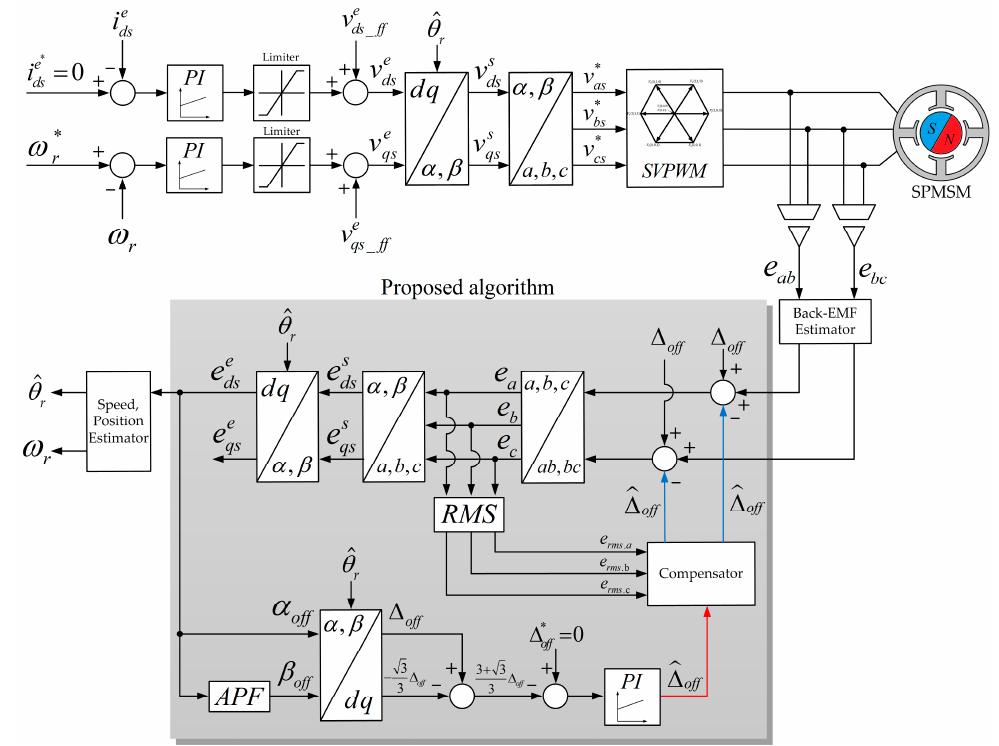
Figure 6. Proposed rotor position estimation algorithm block diagram.